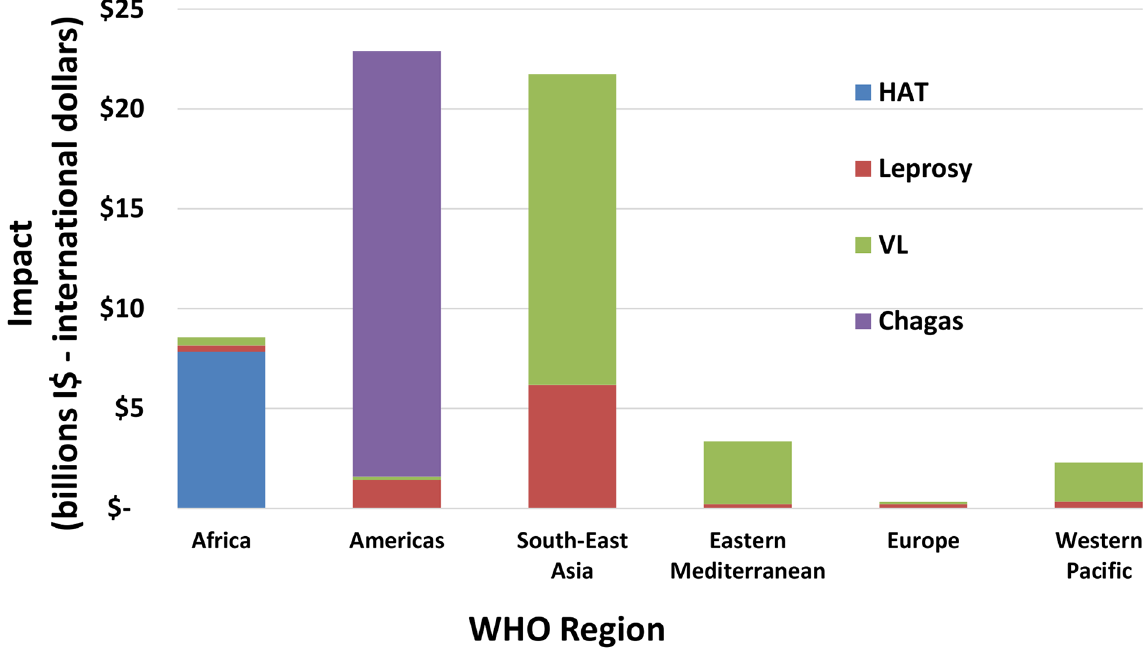
Fig 5. Regional economic benefit (productivity loss averted) for IDM NTDs, for the period 2011–2030 (billions I$—International dollars) per WHO region. Regional economic benefit from reaching the targets for IDM NTDs, for the period 2011–2030 per WHO region.